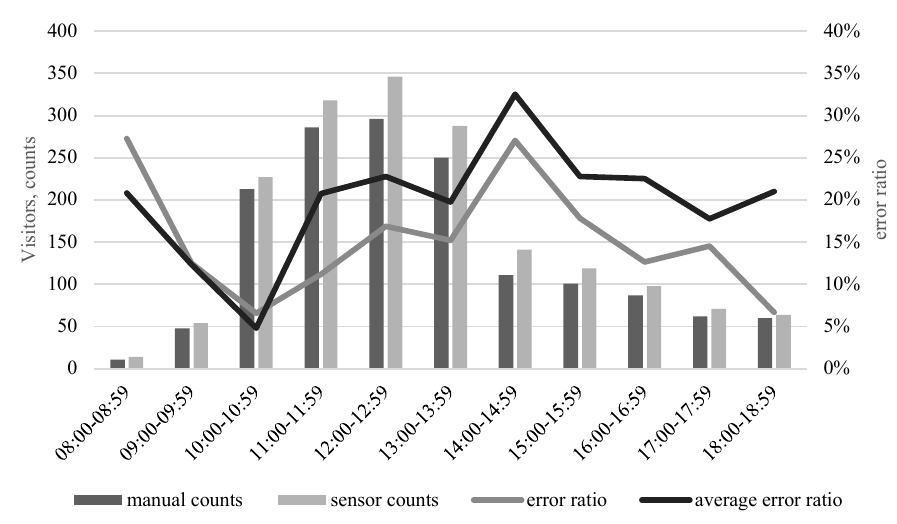
Fig. 2. Error counts by the pyroelectric sensor, aggregated hourly (Szczeliniec Wielki, August 3,